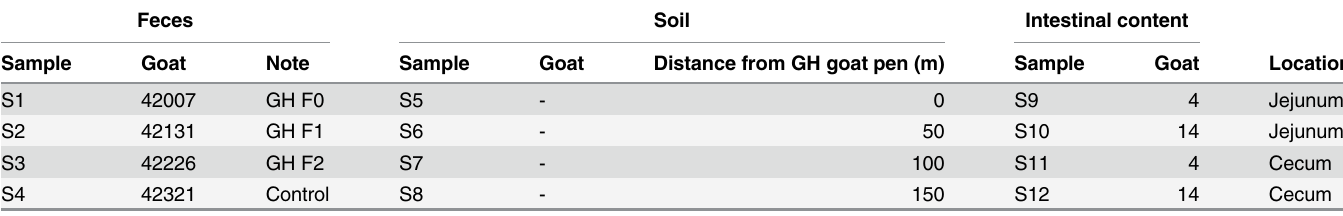
Table 2. Feces, soil and intestinal content samples.